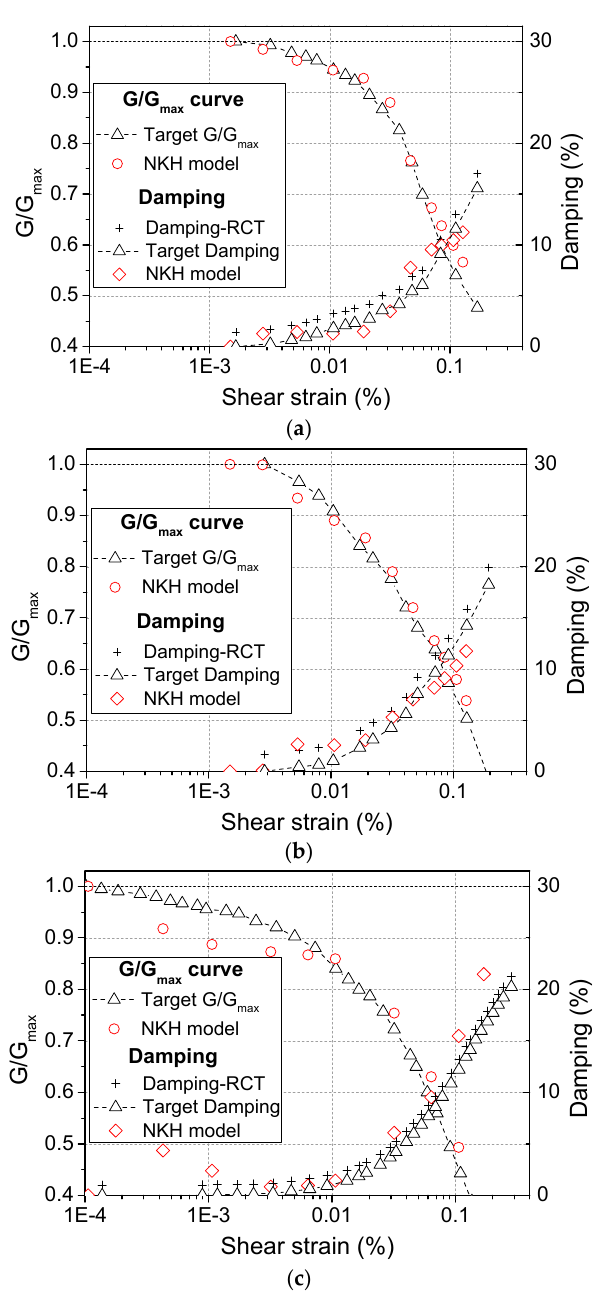
Figure 8. G/G max and damping curves with initial parameters of the NKH model for ( a ) silica sand, ( b ) mixture soil, and ( c ) Toyoura sand.